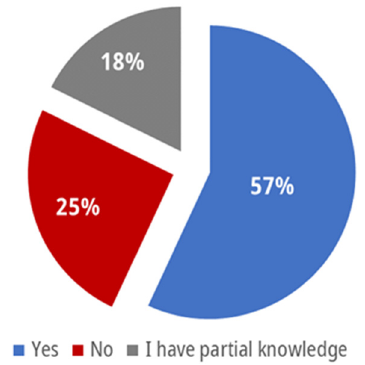
Figure A6. Responses to question (10).